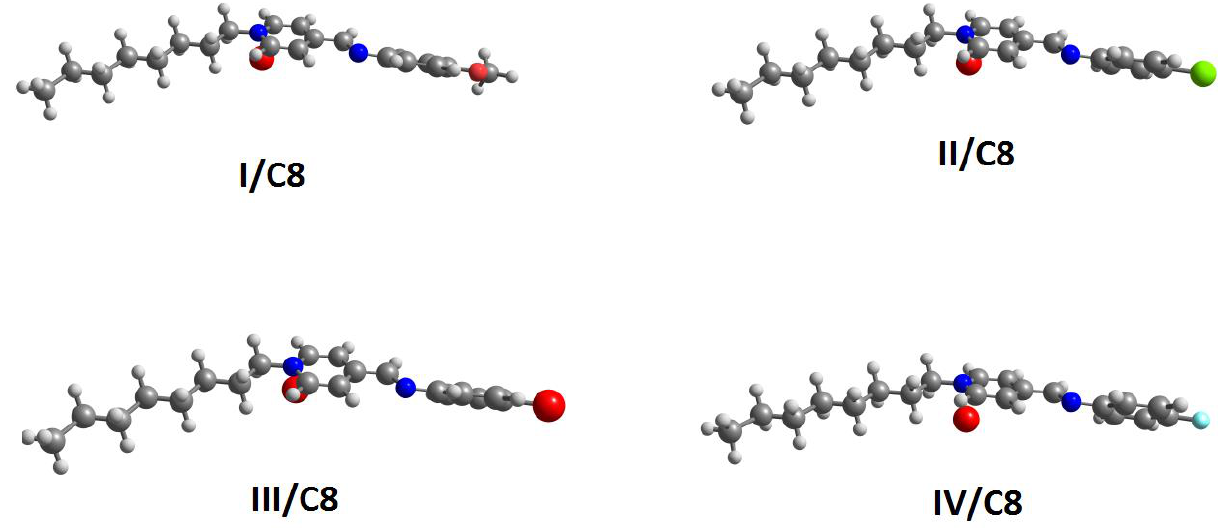
Figure 3. Calculated molecular geometrical the investigated compounds (I-IV)C8.